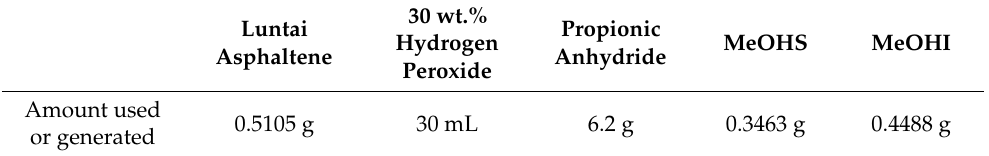
Table 1. Reagent dosage in hydrogen peroxide–propionic anhydride oxidation of asphaltene.